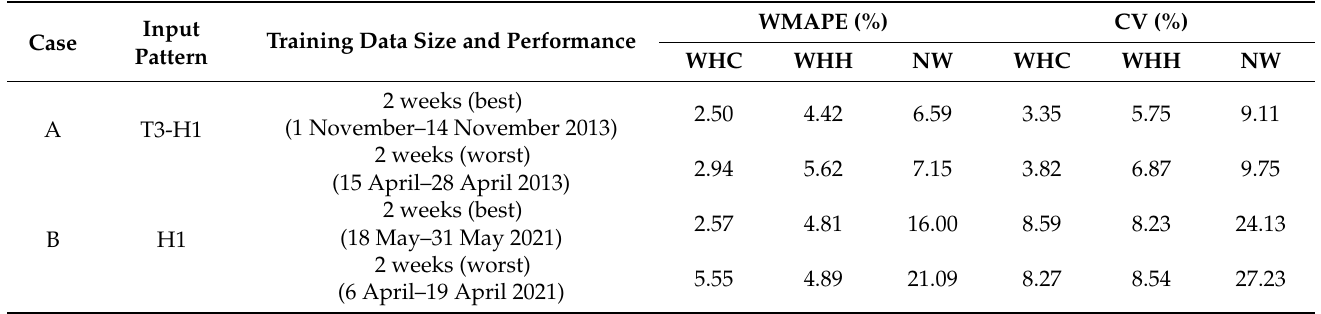
Table 9. The input parameters, training periods and disaggregation estimation errors of the model in Case A and Case B.